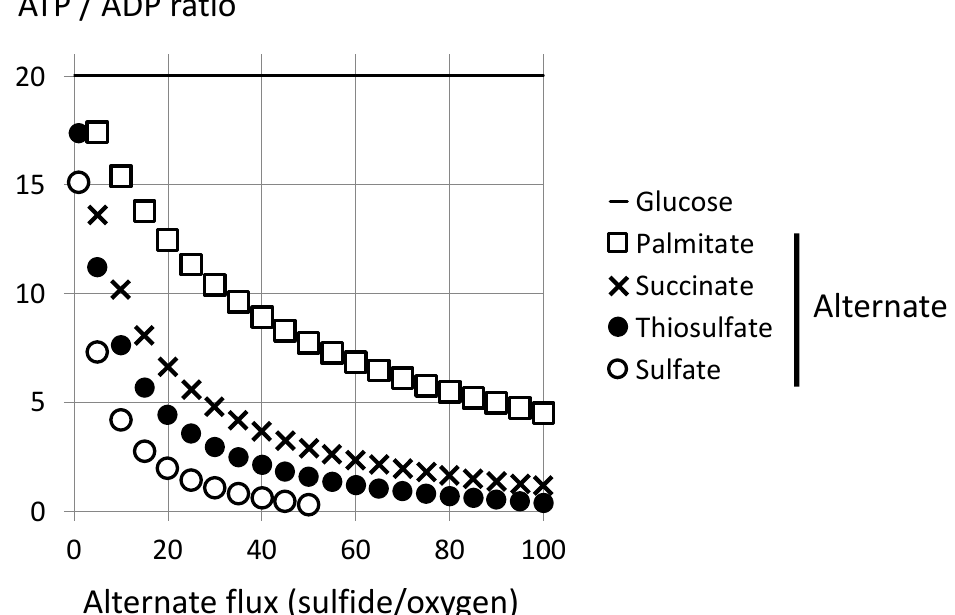
Figure 9. Impact of sulfide oxidation under oxygen limitation. The model states that (1) oxygen supply is the limiting factor; a fixed oxygen amount is used. (2) With this amount of oxygen, the endogenous respiratory rate with the reference substrate (glucose) would regenerate once each cellular ATP molecule (hence for a time period allowing one cycle of turnover of intracellular ATP content). (3) The decrease in ATP regeneration rate caused by intervention of alternate pathways of oxidation results in an equal increase in ADP (no decrease in cellular ATP consumption). For calculation, we consider a reference cycle with 100 oxygen (O 2 ) and an ATP/ADP ratio with a value set to 20, hence 570 ATP and 28.5 ADP. The X axis represents the number of oxygen molecules used for oxidation of the alternate substrates: palmitate (ATP/O 2 = 5) or succinate (SDH reaction only ATP/O 2 = 3.2). With regard to the alternate substrate sulfide, the X axis represents the number of sulfide molecules consumed, and oxidation into sulfate or thiosulfate only is considered. Sulfate formation consumes two oxygen per sulfide, and therefore the corresponding curve ends with X = 50. The Y axis represents the new cellular ATP/ADP ratio after one cycle and for increasing contribution of the alternate pathways from zero to 100 with increment of five. In addition, the values are shown for X = 1 if the substrate is sulfide. The horizontal black line represents the reference value (20) for the steady state of ATP/ADP ratio with endogenous respiration oxidizing glucose.